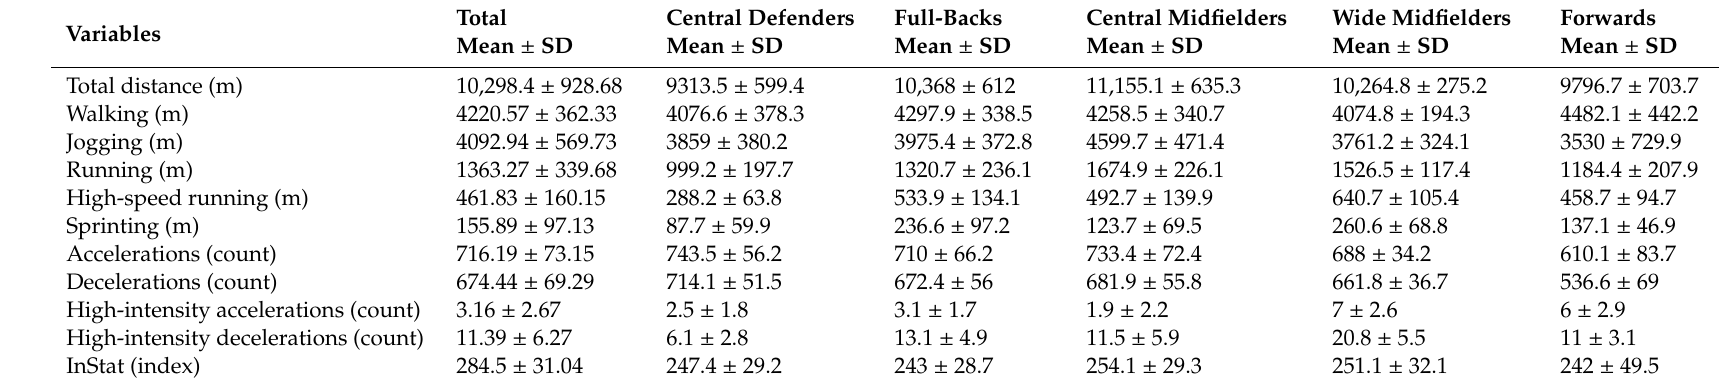
Table 2. Descriptive statistics for running performances and game performance indicator (InStat).